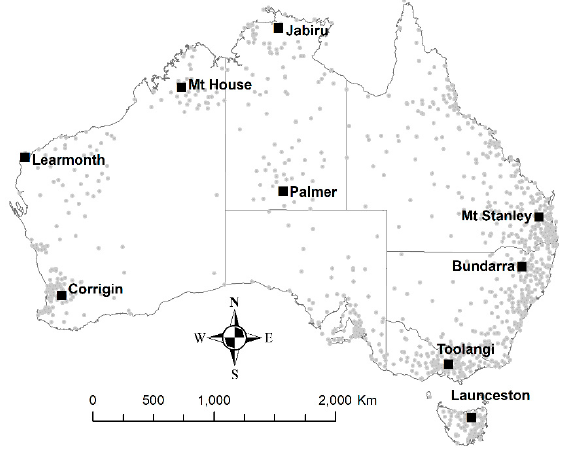
Figure 1. Location of the studied stations (grey dots). Case study stations are named and represented by squares.